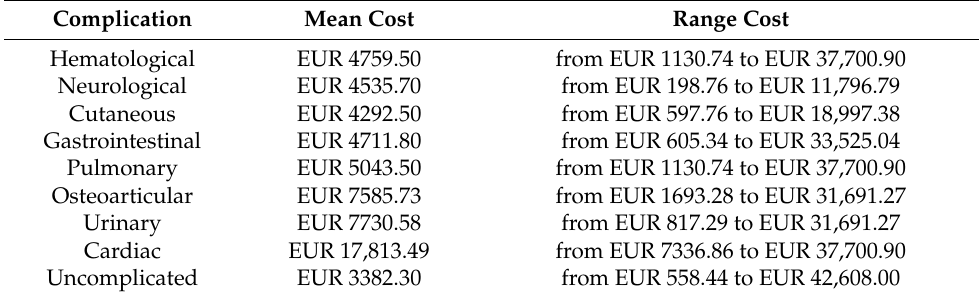
Table 1. Varicella hospitalization acute cost.